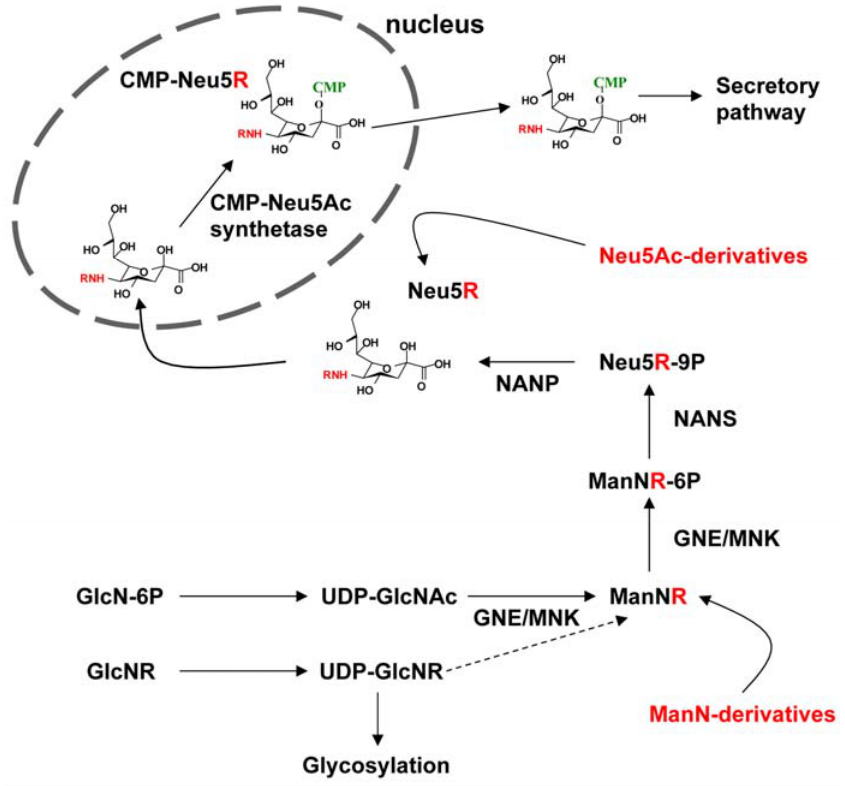
Figure 1. Biosynthetic pathway of sialic acids and feasible implementations of artificial